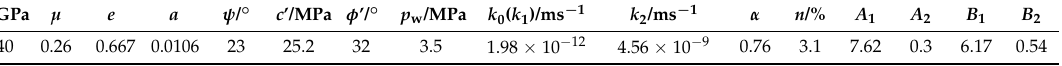
Table 3. Calculation parameters of sandstone (rock samples).